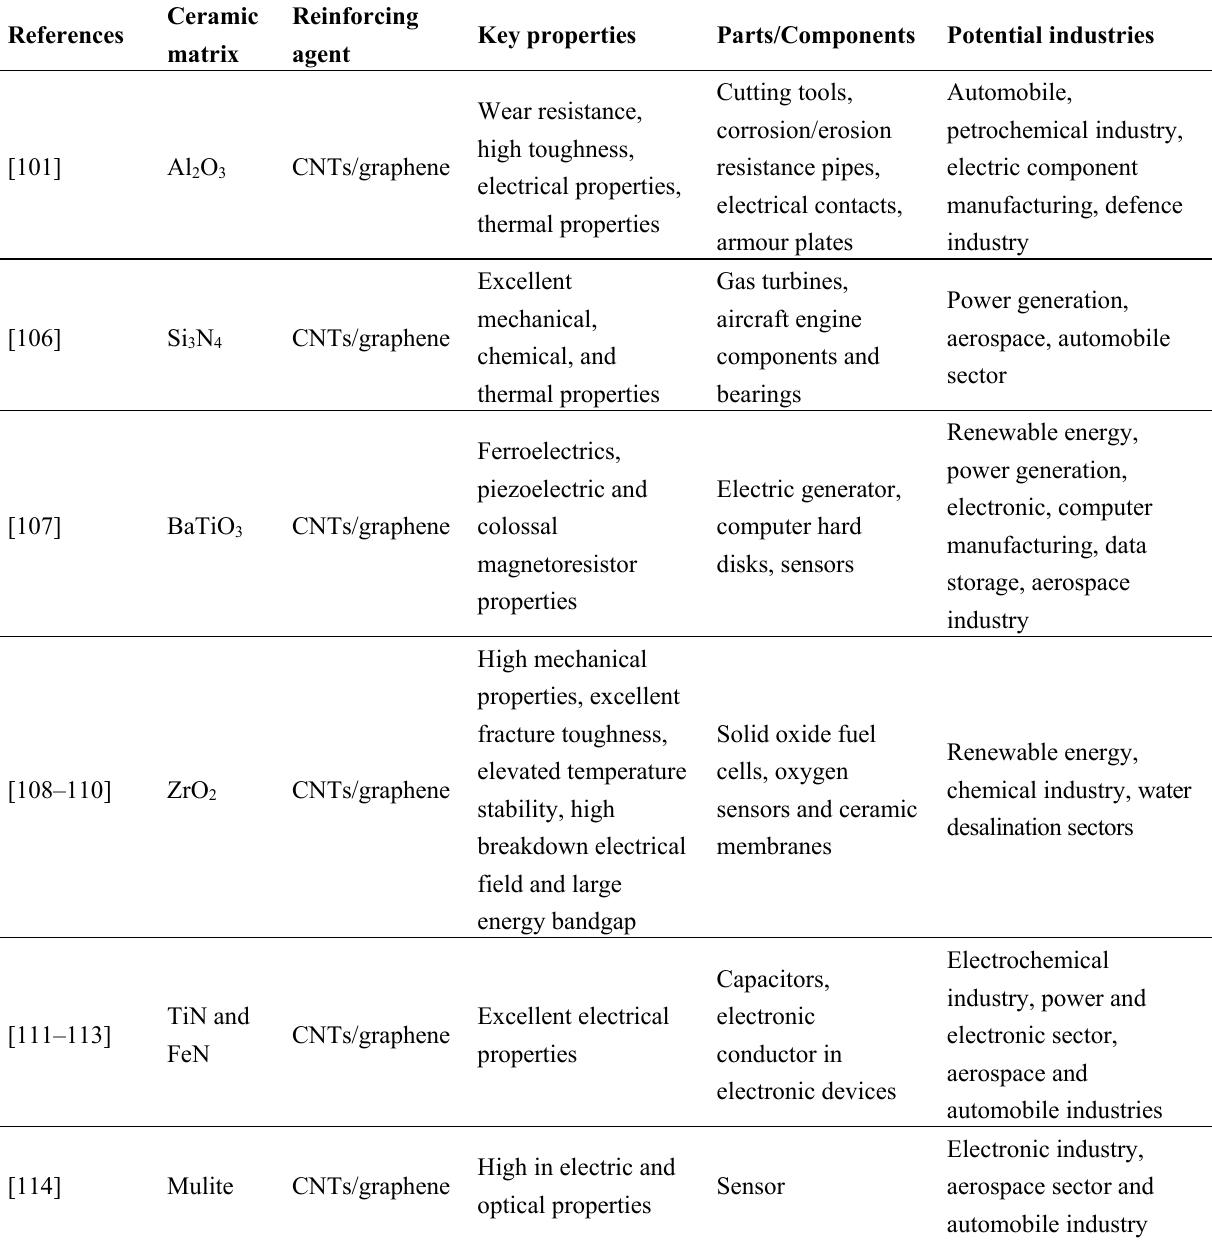
Table 3. Potential application of key ceramics nanocomposites reinforced with CNTs and